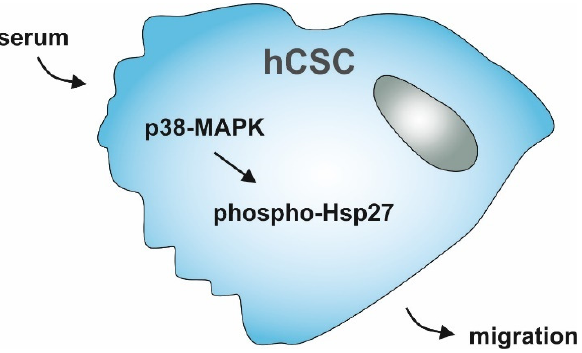
Figure 6. Schematic summary of hCSC-migration upon serum-treatment regulated by p38-MAPK and Hsp27.